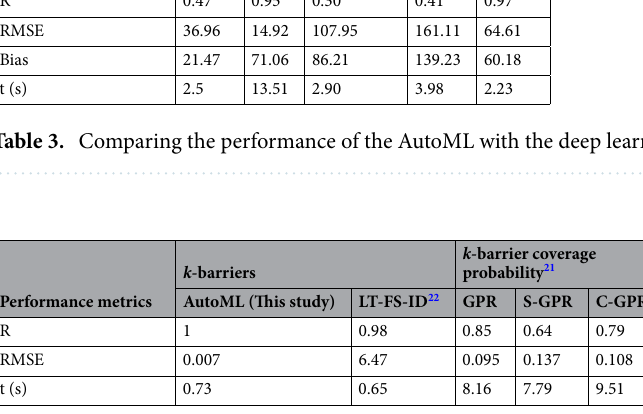
Table 4. Comparing the results of AutoML with previous